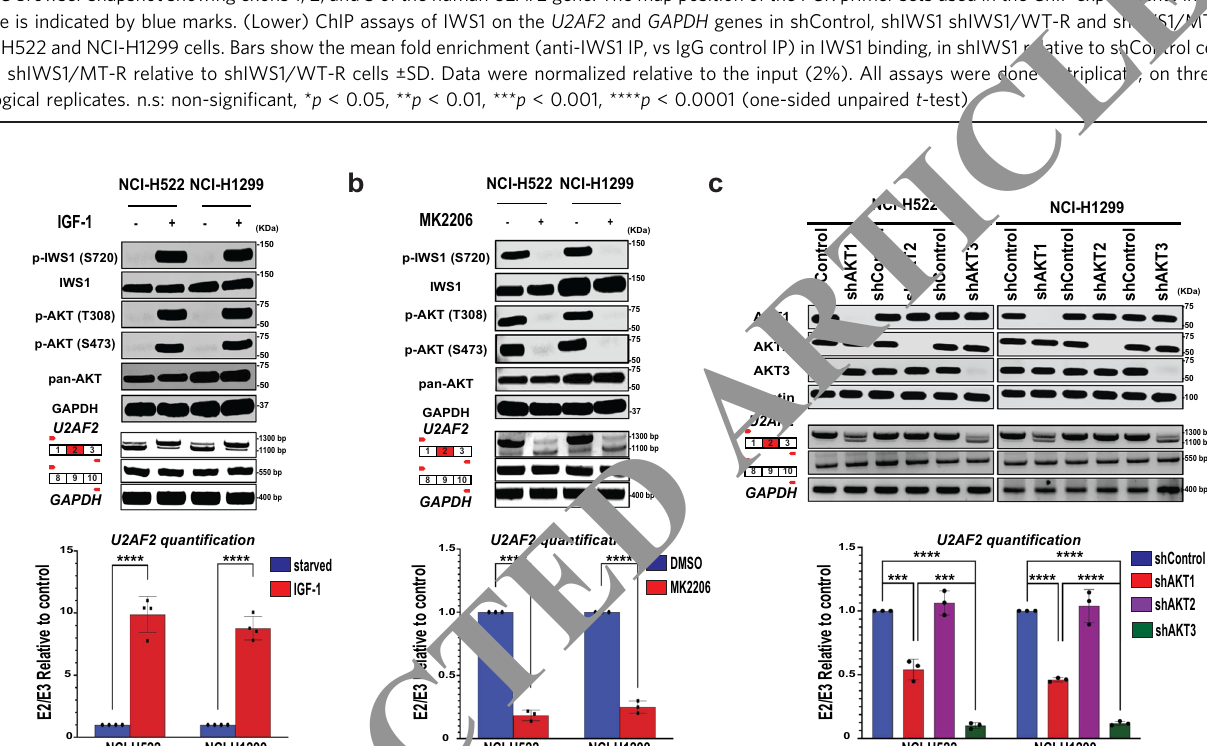
Fig. 2 IWS1 phosphorylation-dependent mRNA splicing of U2AF2 is regulated by serum and IGF-1-induced signals, transduced by AKT3. a (Upper panel) Following serum starvation for 24 h, NCI-H522 and NC-H1299 cells were stimulated with IGF-1 or harvested. Four hours later, the stimulated cells were lysed and all the lysates were probed with the indicated antibodies. (Middle panel) RT-PCR with mRNA derived from the cells shown in the upper panel and oligonucleotide primers mapping to exons 1 and 3 of the U2AF2 gene (Lower panel) The U2AF2 gene E2/E3 ratio was calculated following quanti fi cation of the RT-PCR products in the middle panel. The bars show this ratio (mean± SD) in IGF1-stimulated and in unstimulated, serum-starved NCI-H522 and NCI-H1299 cells. b (Upper panel) Lysates of NCI-H522 and NCI-H1299 cells, treated with MK2206 (5 μ M) or DMSO for 4 h, were probed with the indicated antibodies. (Middle panel) RT-PCR reactions, using mRNA derived from the cells in the upper panel and oligonucleotide primers mapping in U2AF2 exons 1 and 3. (Lower panel) The U2AF2 mRNA E2/E3 ratio was calculated following quanti fi cation of the RT-PCR products in the middle panel. The bars show this ratio (mean± SD) in MK2206-treated (5 μ M) and in DMSO-treated NCI-H522 and NCI-H1299 cells. c (Upper panel) Lysates of NCI-H522 and NCI-H1299 cells, transduced with shControl, shAKT1, shAKT2, or shAKT3, were probed with the indicated antibodies. (Middle panel) RT- PCR reactions, using mRNA derived from the cells in the upper panel and oligonucleotide primers mapping in U2AF2 exons 1 and 3 show that knocking down AKT3, and to a lesser extent AKT1, inhibits the inclusion of exon 2 in mature U2AF2 mRNA transcripts in both cell lines. (Lower panel) The U2AF2 E2/E3 ratio was calculated following quanti fi cation of the RT-PCR products in the middle panel. The bars show this ratio (mean ± SD) in shControl, shAKT1, shAKT2 and shAKT3 NCI-H522 and NCI-H1299 cells. All experiments in this fi gure were done in triplicate, on three biological replicates. n.s: non- signi fi cant, * p < 0.05, ** p < 0.01, *** p < 0.001, **** p < 0.0001 (one-sided unpaired t -test). constructs, and we examined the effects of the transduction on inhibits both AKT and IWS1 phosphorylation and U2AF2 exon 2 the alternative RNA of splicing of U2AF2 and FGFR2 . The results inclusion (Fig. 2b, Supplementary Fig 2b, upper panels). The (Fig. 2c, Supplementary Fig. 2c) con fi rmed that only the knock- same treatment also increased the relative abundance of the exon down of AKT1 and AKT3 phenocopies the MK2206 results and 8-containing IIIb transcript of FGFR2 (Supplementary Fig. 2b that the effect of the AKT3 knockdown is signi fi cantly more lower panel), as expected. To determine whether it is the AKT3 robust than the effect of the AKT1 knockdown. These fi ndings isoform of AKT, which is responsible for these shifts in alter- are consistent with the phosphorylation of IWS1 primarily by native RNA splicing, we transduced NCI-H522 and NCI-H1299 AKT3, and strongly support the hypothesis that the cells with shControl, shAKT1, shAKT2, or shAKT3 lentiviral NATURE COMMUNICATIONS| (2021) 12:4624